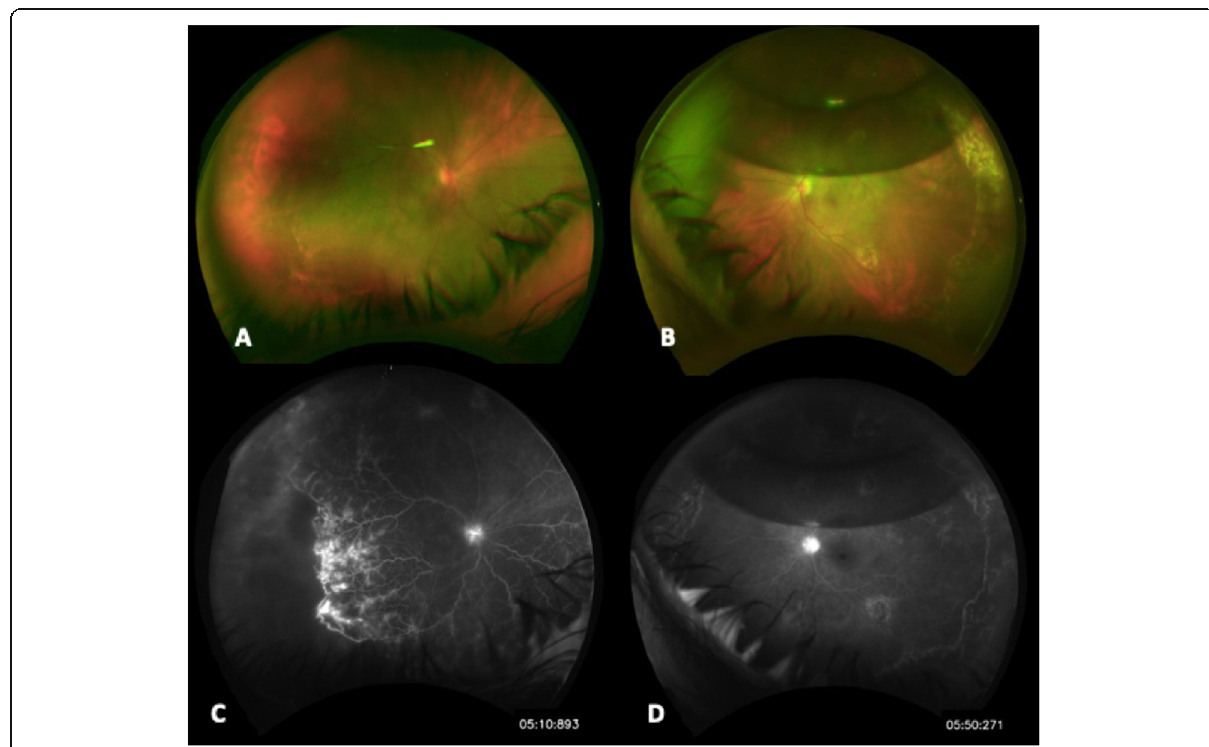
Fig. 3 a Color fundus photograph of the right eye with inferotemporal RRD macula off. b Color fundus photograph of the left eye with macula attached and periphery with laser scars more evident temporally. Mid-periphery chorioretinal scar from drainage and superior C3F8 bubble with 40% fill. c Fluorescein angiography of the right eye late images demonstrating disk hyperfluorescence, temporal nonperfusion, and vascular staining and leakage in the area of the retinal detachment. Mild macular hyperfluorescence is present. d FA of the left eye, the late images demonstrating disk staining, and no other abnormal hyperfluorescence other than staining of postsurgical laser scars